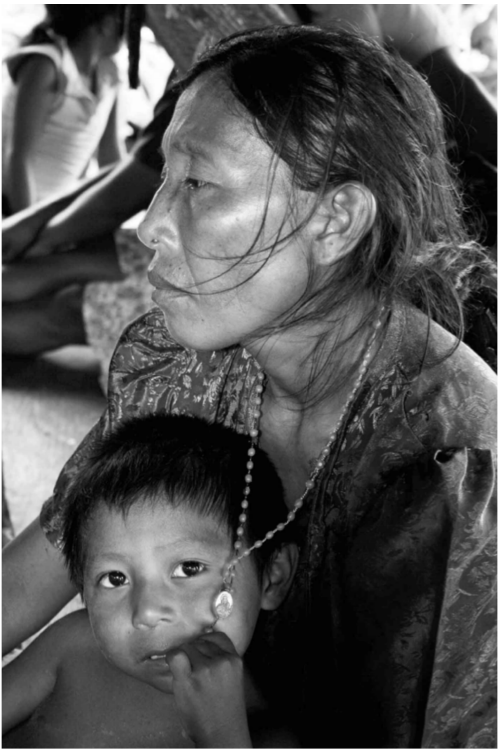
Figure 1. Holding her son Romeliano, Anita Rivas watches her husband, Arsenio Torres, sing a lament over the body of their daughter, Elbia Torres Rivas; Barranquita, Venezuela, 2008. Photograph by Charles L.